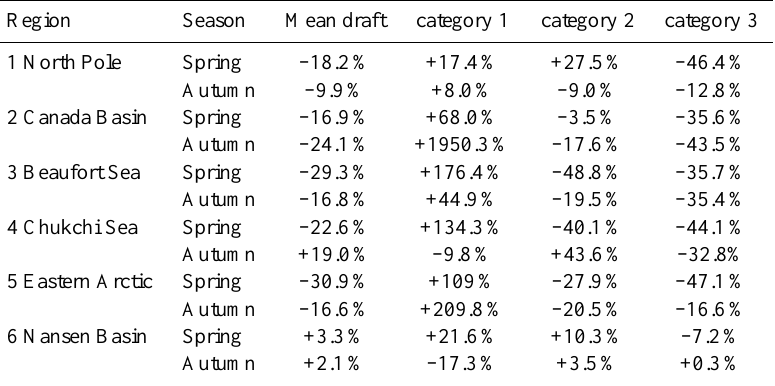
Table 3. Difference in the mean ice draft and in the volume of three ice categories between the periods 1975–1987 and 1988–2000. Ice category 1 consists of ice with draft < 2m in Spring and < 1m in Autumn, ice category 2 includes draft range 2–5m in Spring and 1–5m in Autumn, and all ice with draft > 5m falls into ice category 3.